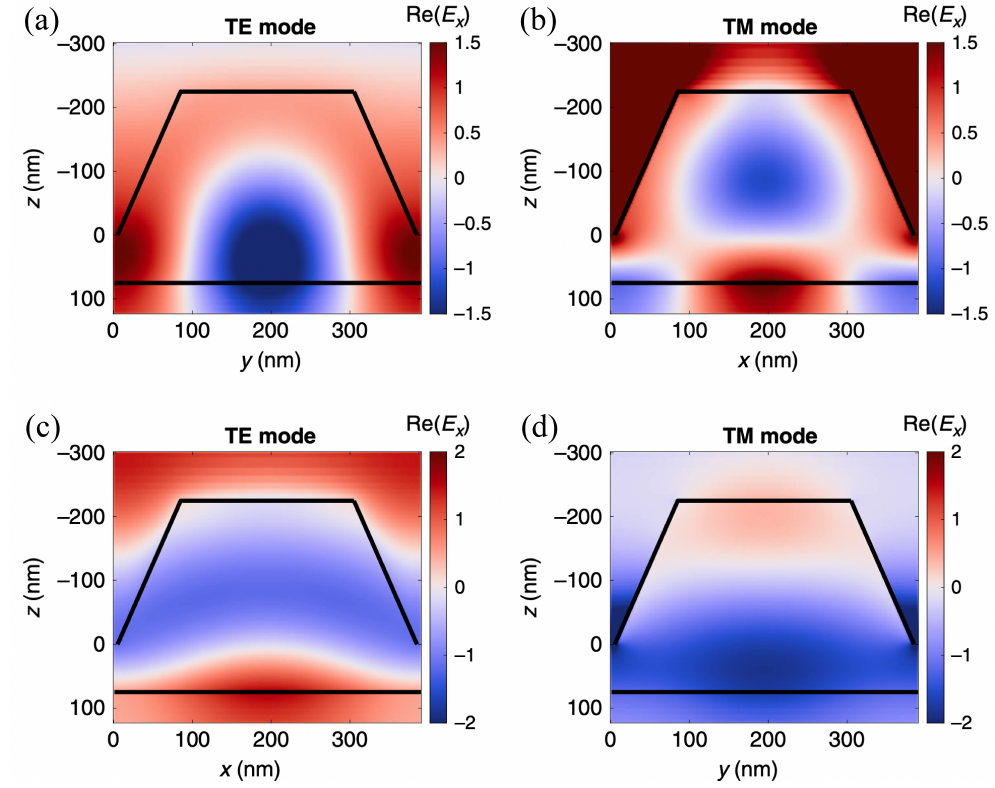
Figure 8. Real part of the electric field component E x associated with the resonant electromagnetic field distributions for the ( a , c ) TE 0,1 (propagating along the y -axis) and ( b , d ) TM 1,0 (propagating along the x -axis) modes. Numerical results, shown inside one period of the metasurface (the cross-sections are taken at the center of the nanopillar), were calculated for a TM incident wave under normal incidence. Adapted with permission from ref. [33]. Copyright 2020 Springer